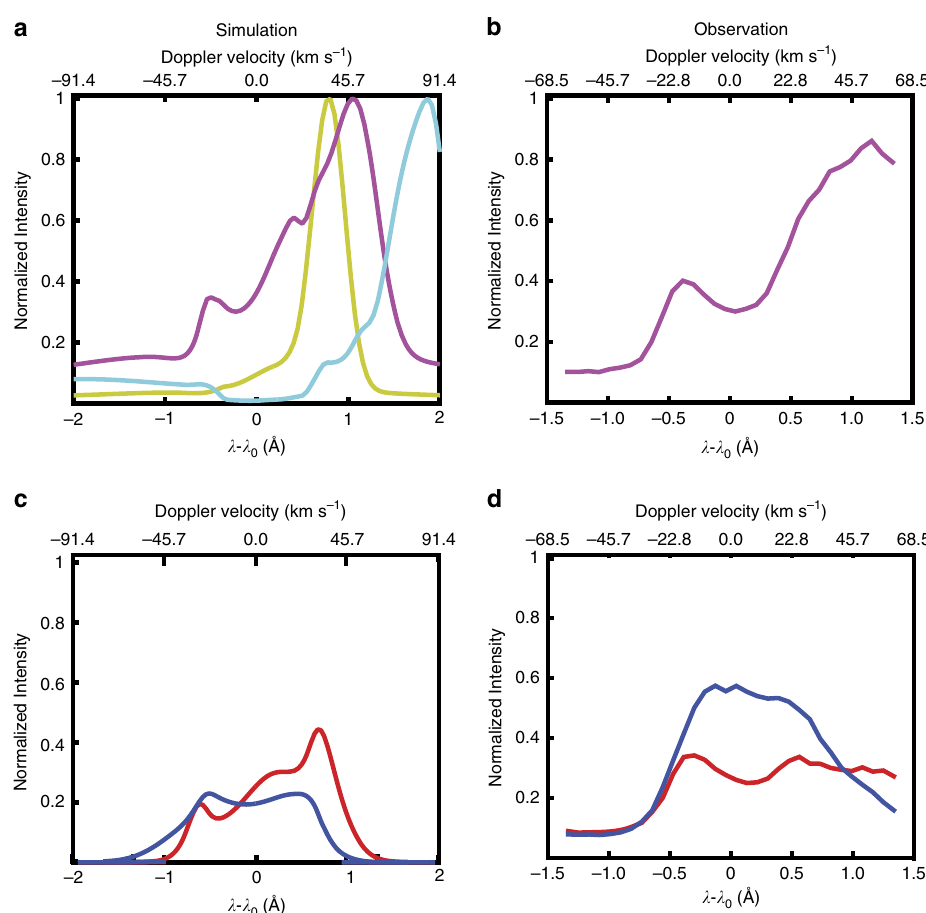
Figure 5 | Simulated and observed H a line enhancements. ( a ) the synthetic H a line normalized intensity versus a distance ( l (cid:2) l 0 ), in Å, from the H a line central wavelength, l 0 ( l 0 ¼ 6563Å) taken from the simulation at þ 5s after a beam onset for the F10 model (magenta line), the 3F10 model (cyan line) and a model with initial flux 7 (cid:3) 10 9 ergcm (cid:2) 2 s (cid:2) 1 (7F9 model, yellow line) ( b ) the normalized background-subtracted H a profile observed þ 7s after the ribbon onset in the event 2. ( c ) The H a line normalized intensity simulated for the F10 model at later times after the beam onset: þ 30s (red solid line) and þ 70s (blue solid line) and ( d ) the observed H a profiles at the similar times of þ 29s (red solid line) and þ 56s (blue solid line) after the event 2